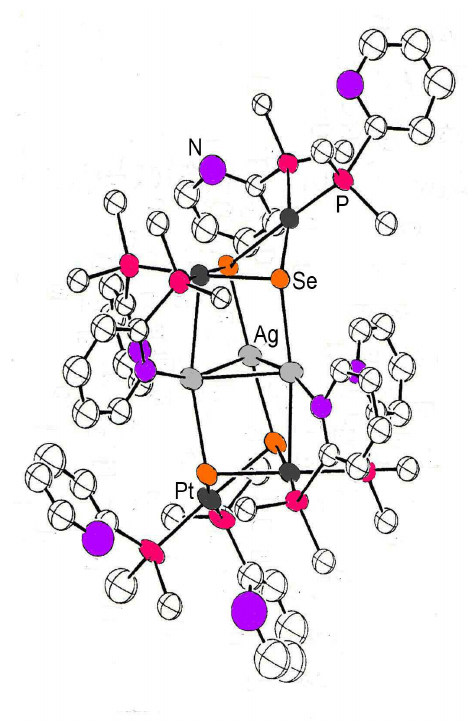
Pt (µ-dppy)(µ 3 2